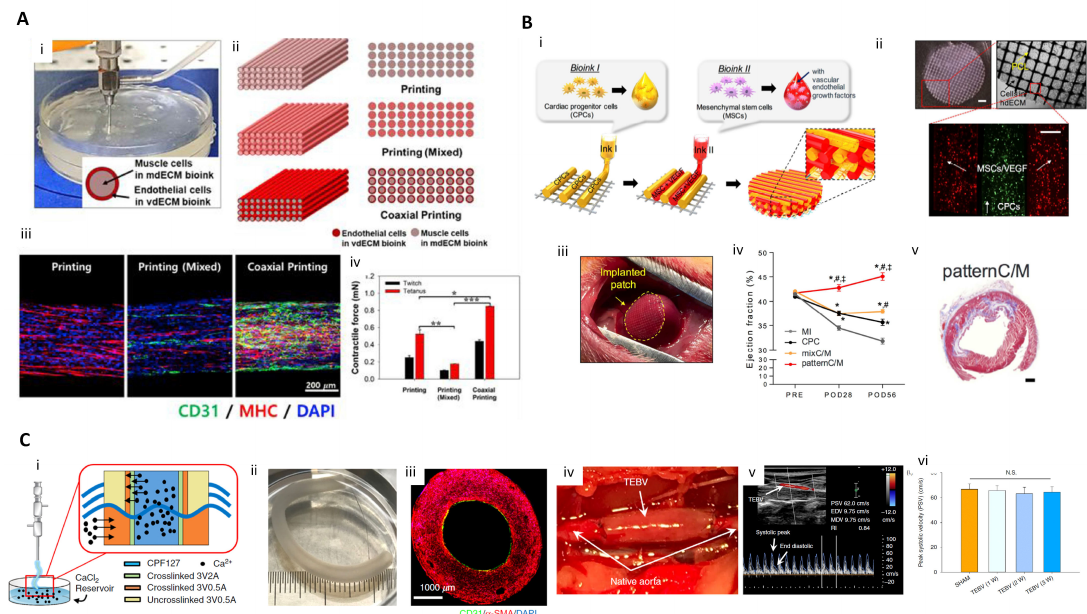
Figure 3. Therapeutic applications of 3D printing for skeletal muscle, cardiac muscle and vasculature regeneration. ( A ) 3D cell printed pre-vascularized muscle construct. (i) 3D cell printing pre-vascularized muscle constructs through a coaxial nozzle; (ii) Schematic illustration of the printing, printing (mixed), andcoaxialprintinggroups. Overallviewsoftheconstructs(left). Cross-sectionalviewsoftheconstructs (right); (iii) IF images of the di ff erent muscle constructs; (iv) Twitch and tetanus forces of the printing, printing (mixed), and coaxial printing groups (n = 5); * p < 0.05, ** p < 0.01, and *** p < 0.001 (reproduced with permission from ref [100]; copyright 2019 Elsevier). ( B ) 3D printed complex tissue construct for cardiac repair. (i) Illustration of pre-vascularized stem cell patch including multiple cell-laden bioinks and supporting PCL polymer; (ii) Fabricated patch including the two types of cell-laden bioink and PCL supporting layer (Scale bar (top left), 1 mm; Scale bar (bottom), 200 µ m); (iii) Photo of implanted patch; (iv) Ejection fraction values at baseline and after 4 and 8 weeks. Error bars represent sem (* p < 0.05 compared with MI; # p < 0.05 compared with CPC; ‡ p < 0.05 compared with mixC / M); (v) Masson’s trichrome staining results of a whole heart for a pattern CPC / MSC group (scale bars, 1mm) (reproduced with permission from ref [151]; copyright 2017 Elsevier). ( C ) Triple-coaxial cell printing-based vascular graft containing endothelium and smooth muscle. (i) A schematic of reservoir-assisted triple-coaxial cell printing; (ii) Triple coaxial cell-printed tissue-engineered blood vessels (TEBVs) with inner diameter of 2 mm and WT of 1 mm; (iii) Cross-sectional view of the vessel including a thin endothelial cell layer and a thick smooth muscle cell layer stained with CD31 and alpha-SMC, respectively; (iv) implanted TEBV as interposition grafts; (v) The flow pulse of the TEBVs showing a regular spectrum composed of rapid-sharp systolic peaks and slow, flat end-diastolic velocity; (vi) the peak systolic velocity of TEBVs showing no significant di ff erences for up to 3 weeks compared to that of normal rats (sham control, N.S: not significant) (reproduced with permission from ref [105]; copyright 2019 AIP